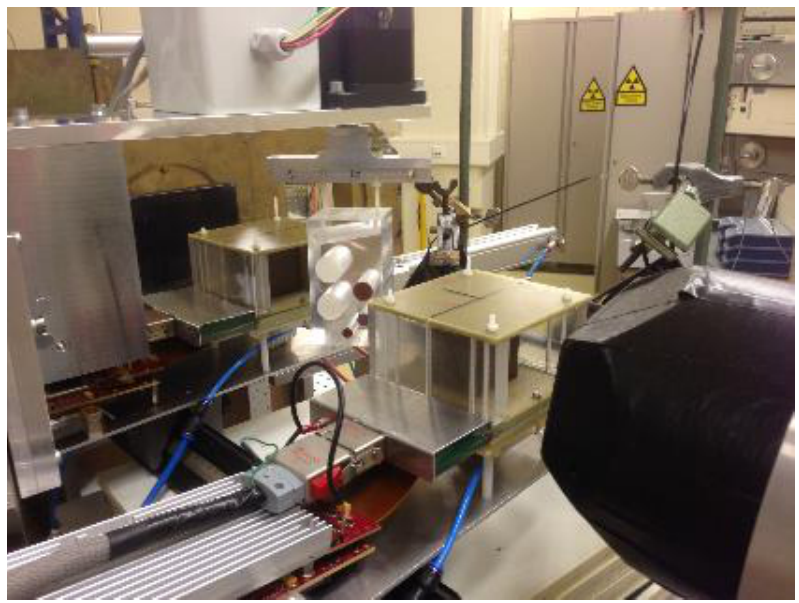
Figure 11. The experimental setup for proton radiography [25].